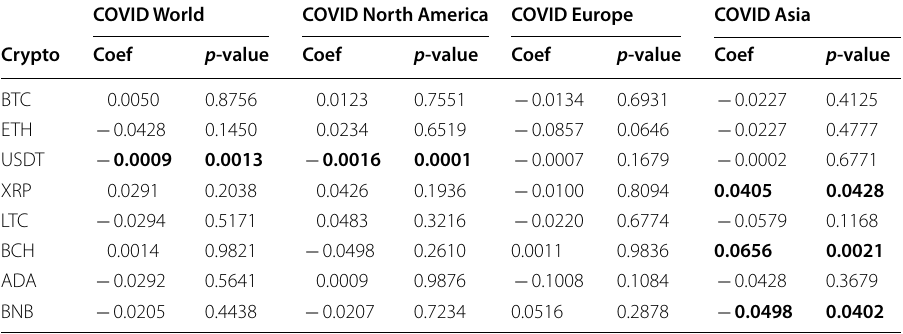
The control variables used for Eq. 2 (COVID‑19 cases worldwide) and Eq. 3 (COVID cases in North America, Europe, and Asia) are CC price return autoregressive terms, DJIA returns lagged, GOLD variations lagged, EURUSD variations lagged, and VIX variations lagged. The bold numbers are coefficients significant at the 5% level. All other parameters of the models are presented in Tables 7 and 8